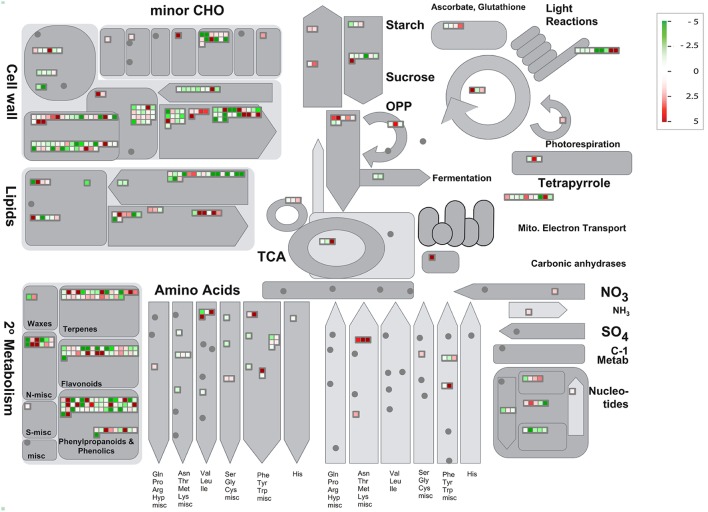
Visualization of functional categories of differentially expressed genes between HLB tolerant “Jackson” and HLB susceptible “Marsh” trees. Each colored square denoted a single annotated gene in a particular pathway. Color gradient between red (up-expressed in HLB tolerant “Jackson” trees compared to HLB susceptible “Marsh” trees) and green (down-expressed in HLB tolerant “Jackson” trees compared to HLB susceptible “Marsh” trees) represented the log fold ratios. Figure created by MapMan (Urbanczyk-Wochniak et al., 2006).